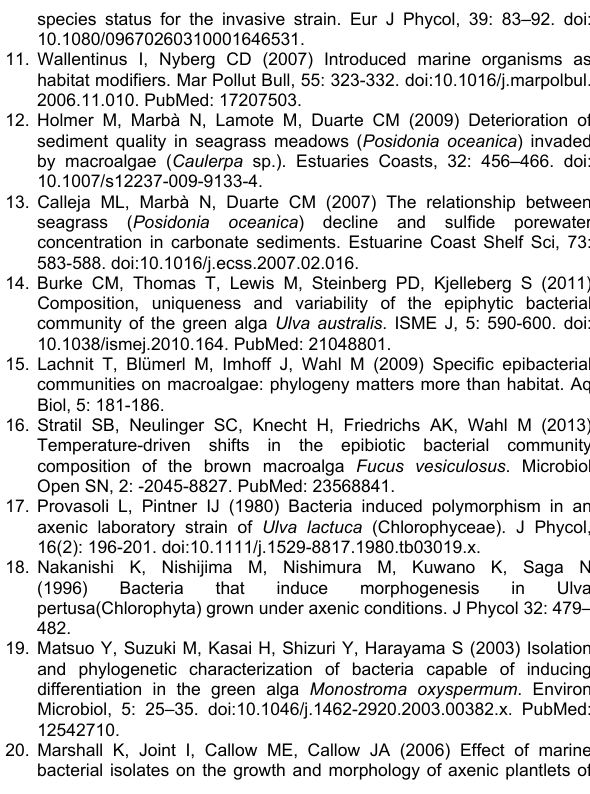
Table S1. Number of sample units (SUs) processed per locality. Placehold legend. Remove.